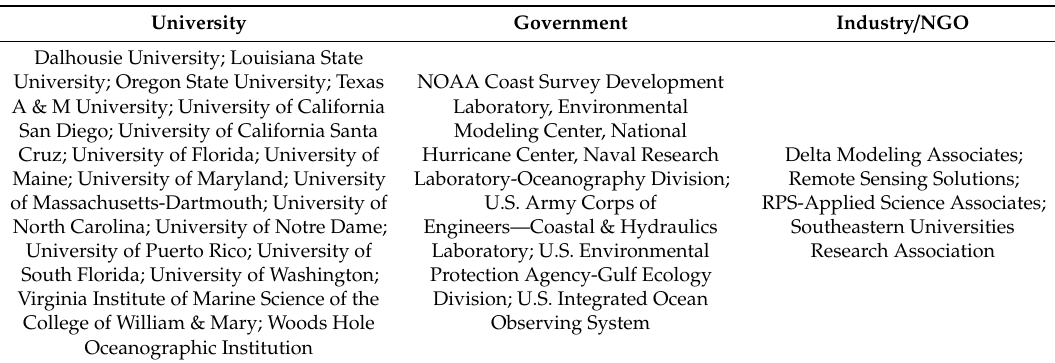
Table 3. Coastal and Ocean Modeling Testbed collaborators and partners. Collaborators were funded to work on projects. Most of the partners from government or the U.S. IOOS Regional Associations joined project teams in pursuit of the shared goal to transition new modeling capabilities to